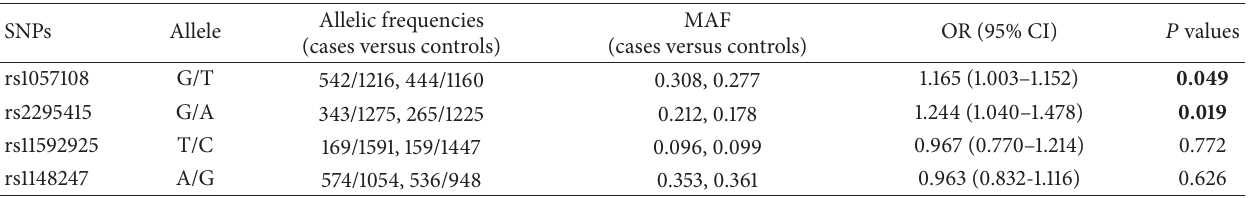
Figure 1: (a) Thirty-six CREM 𝛼 SNPs were shown with linkage disequilibrium (LD); the intensity of LD is reflected in the color and digital value of each box. (b) The LD structure and location of four tagSNPs. Red represents strong linkage; white represents no linkage. Digital value in each box represents the 𝐷 󸀠 values × 100 for linkage disequilibrium between the two corresponding SNPs; the maximum 𝐷 󸀠 value is 1, which indicates complete linkage. Table 2: Allele analysis of CREM 𝛼 tagSNPs in SLE